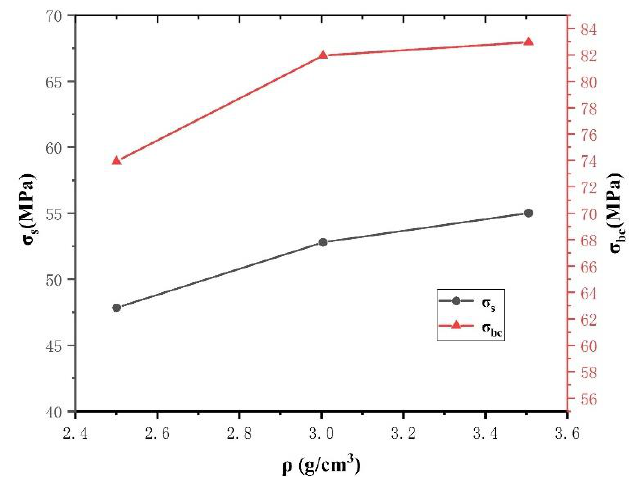
Figure 8. Effect of density on dynamic compression properties of PTFE/Cu.